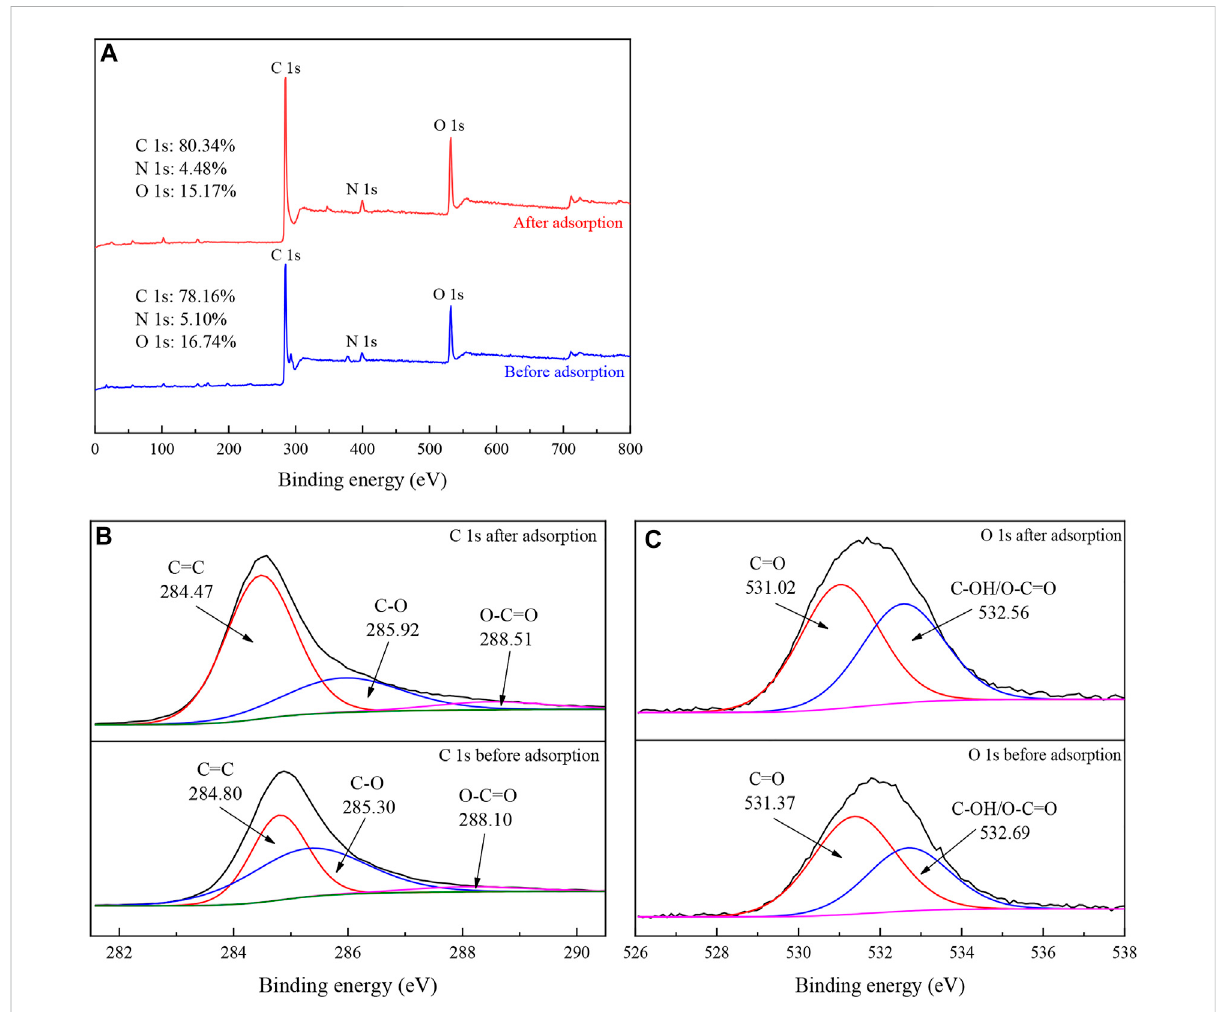
FIGURE 10 XPS spectra of IKBCH before and after TC adsorption: (A) Survey spectra; (B) C1s spectra; (C) O1s spectra.